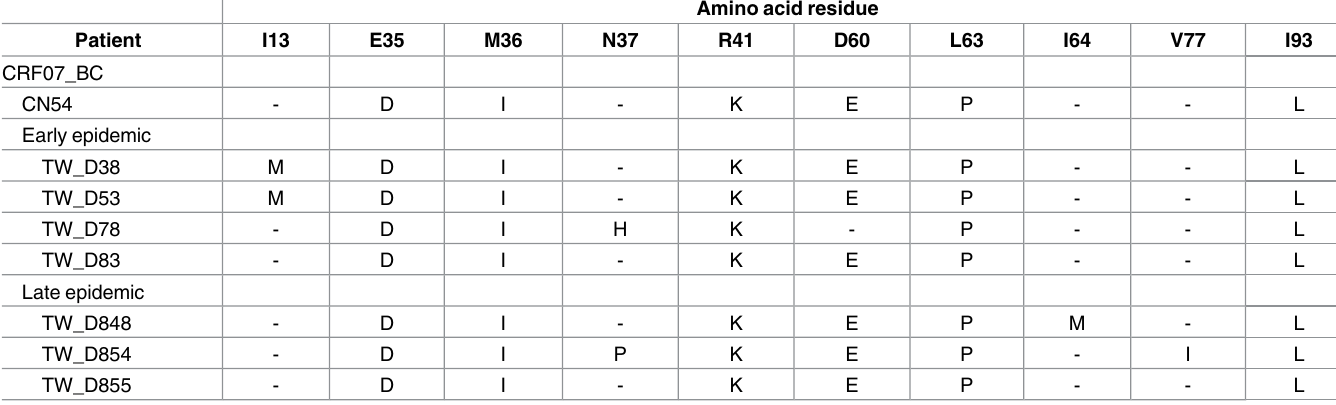
Table 5. Correlation between the phenotypic drug susceptibility and low frequency variants in Taiwanese CRF07_BC early epidemic isolates.